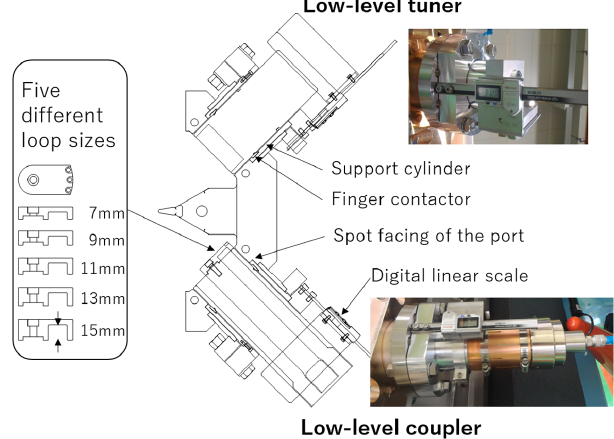
FIG. 10. Tuner and coupler used for low-level tuning.